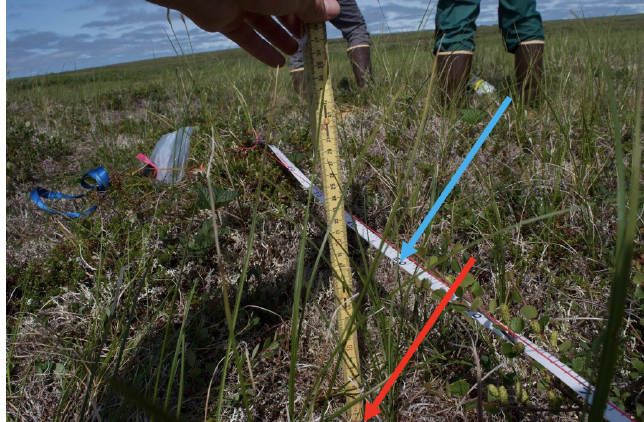
Figure A2. Measurement from the taut string to the dense vegetative layer (red arrow) in an unburned area every 25cm (blue arrow).